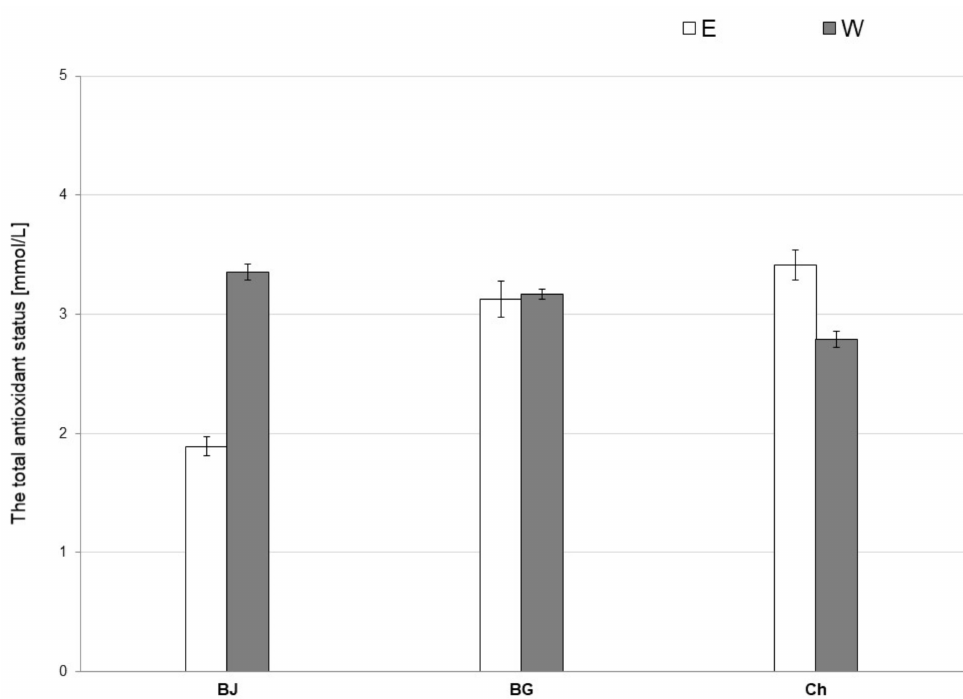
Figure 2. Total antioxidant status (TAS) of 70% ethanolic (E) and water (W) extracts from young barley juice (BJ), barley grass (BG) and chlorophyll